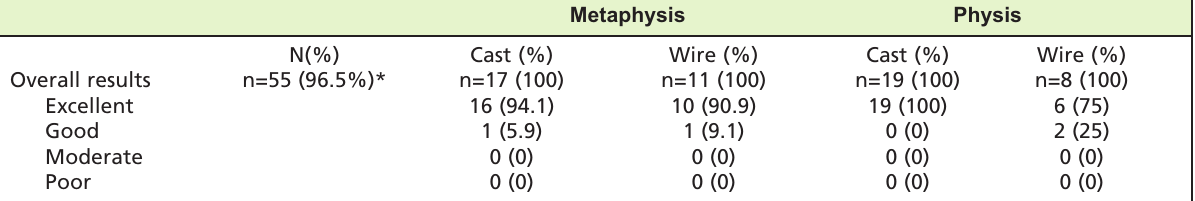
Overall outcomes at skeletal maturity according to scoring by Zimmermann et al Table VII: